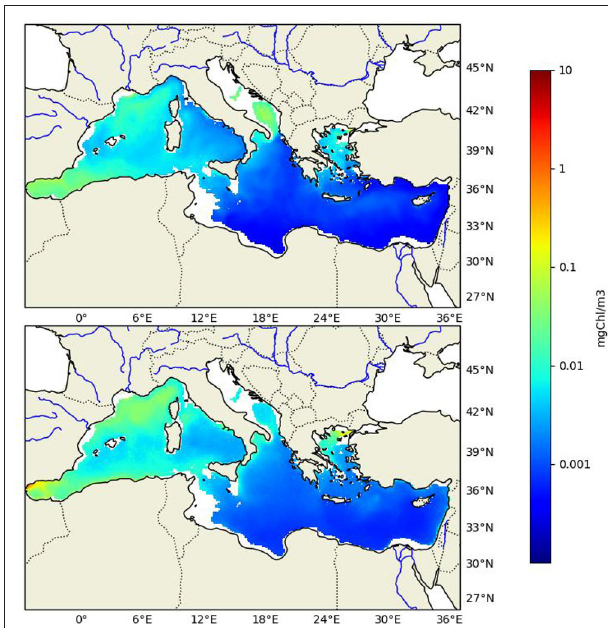
FIGURE 2 | Average surface chlorophyll a concentration (excluding areas with depths < 200 m) between 1999 and 2006, (top) calculated by the model and (bottom) observed by satellite (satellite data provided by CMEMS, more information in Barale and Gade,